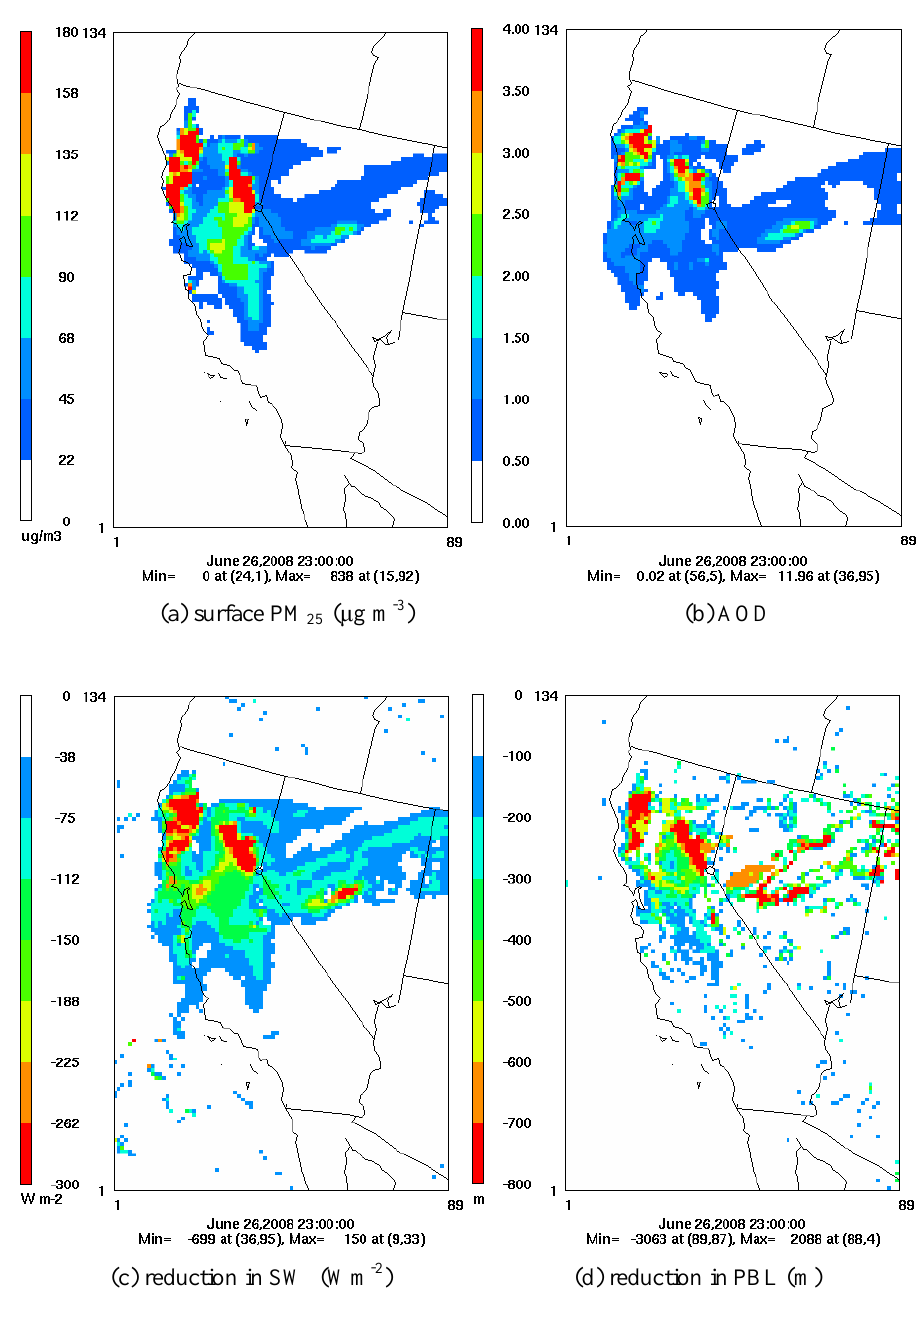
Figure 6. Illustration of the direct radiative effects of aerosols simulated by the coupled WRF-CMAQ model at 22 UTC on June 25, 2008. 7